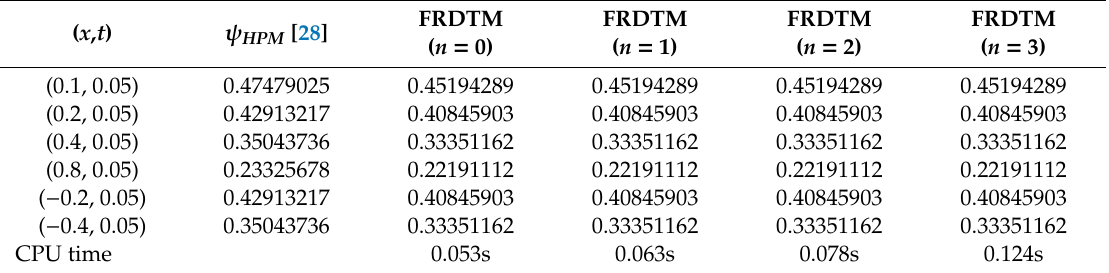
Table 2. The two term FRDTM approximation results of CH equation with HPM [28] for α = 1.